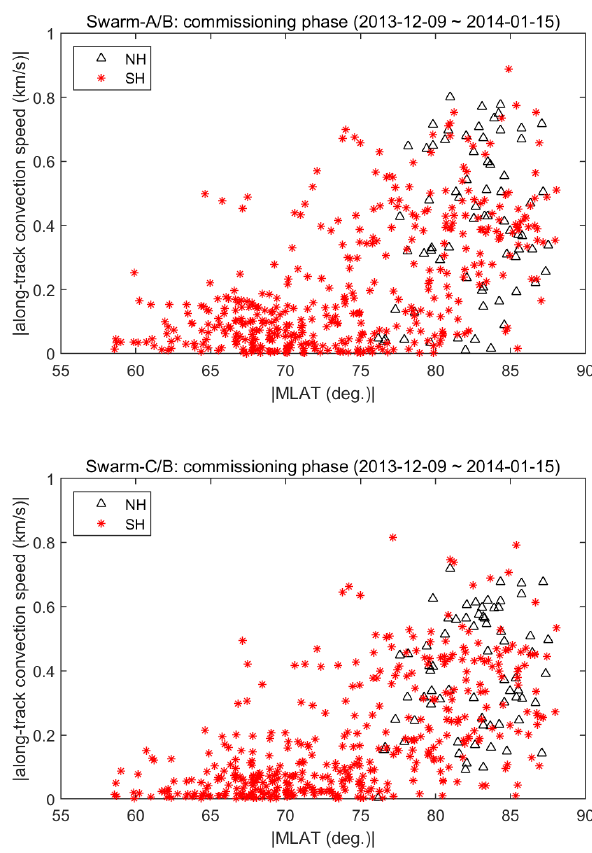
Figure 4. | MLAT | dependence of the along-track plasma drift speed obtained by (a) the Swarm-B–A pair and (b) by the Swarm-B–C